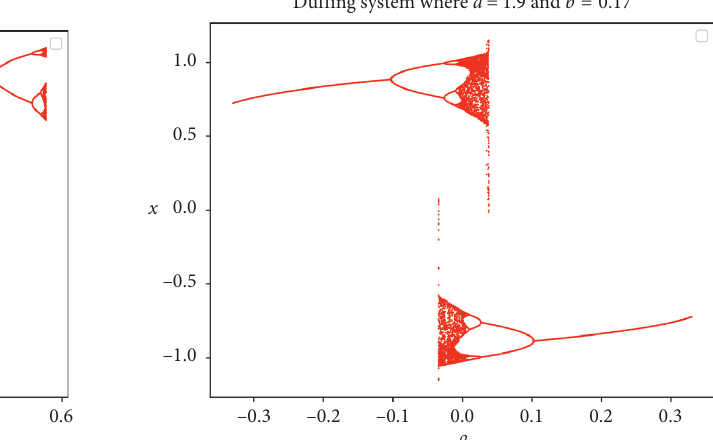
Duffing system where a = 1.9 and b = 0.17